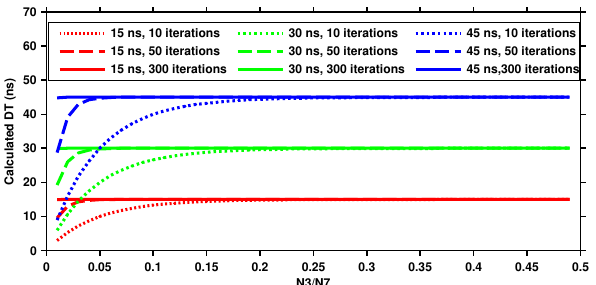
Figure 2. DT as derived by the standard Brewer software as a func- tion of the ratio of signals at slit-mask positions 3 and 7 ( N 3 /N 7 ) and for three different reference DT values (15, 30 and 45ns) using 10, 50 and 280 iterations.